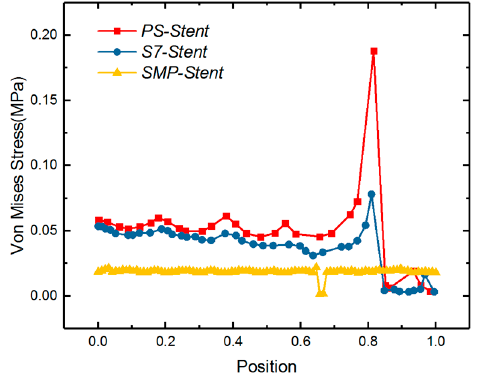
Figure 10. Von Mises stress comparison of length normalized vessel under expansion of three types of stent: balloon-expandable Palmaz–Schatz (Ps) stent, S670 stent [38], and SMP stent.